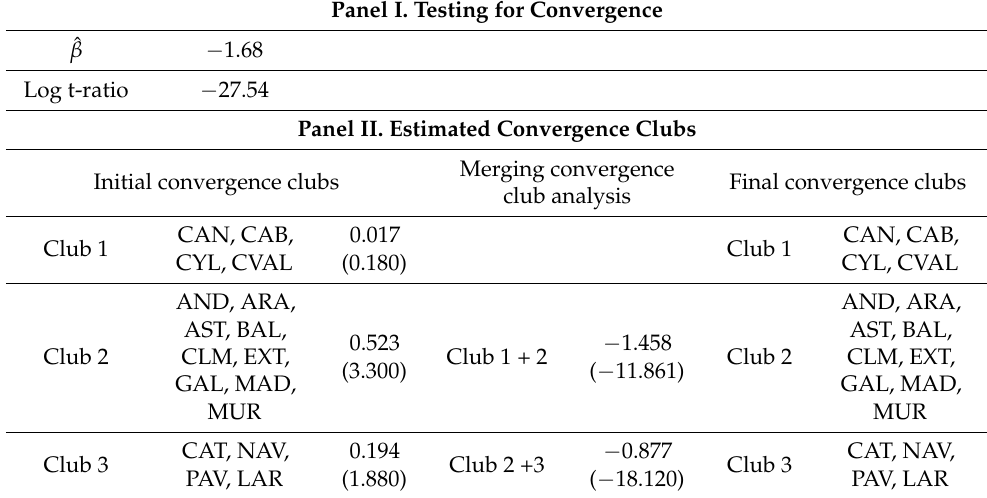
Table 2. Testing for convergence. Panel I. Testing for